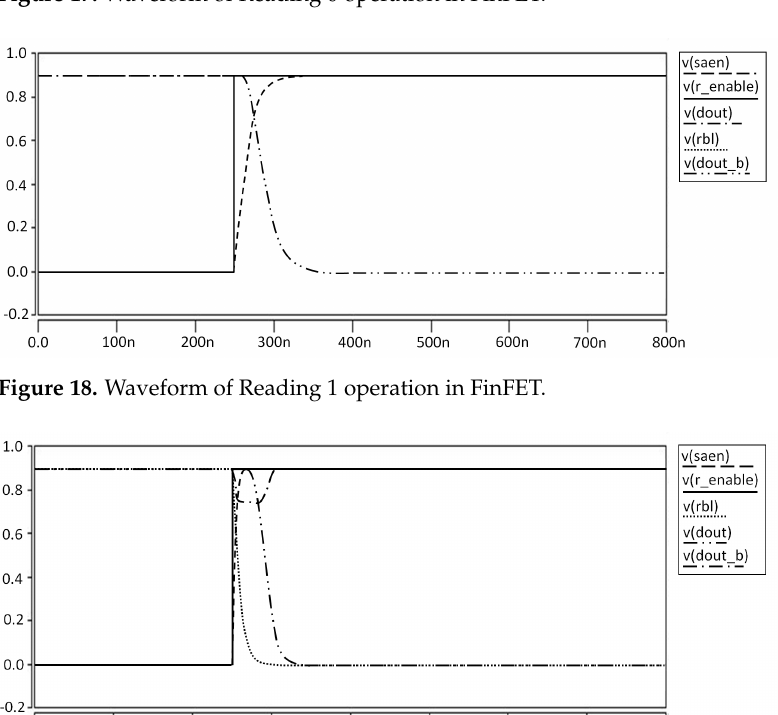
Figure 17. Waveform of Reading 0 operation in FinFET.